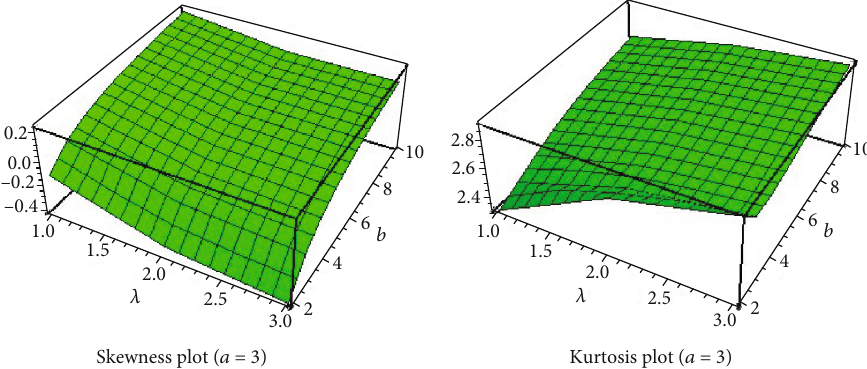
Figure 5: Graphs of skewness and kurtosis of TIIHLKw